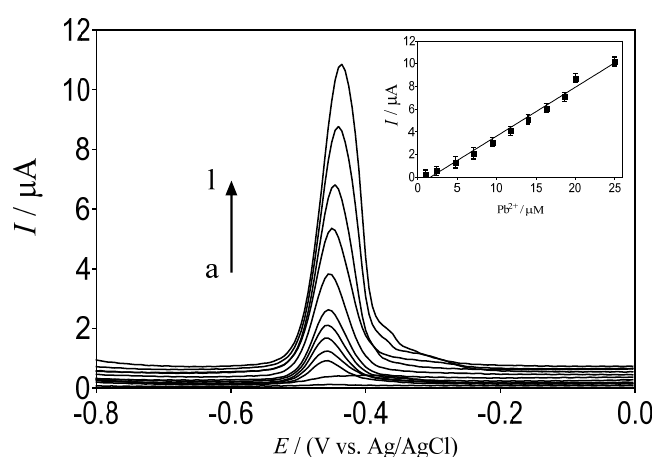
Figure 4. SWASV curves of GrRAC-70% recorded for different concentrations of Pb(II) in 0.5 M H 2 SO 4 : (a) 0, (b) 1.2, (c) 2.4, (d) 4.8, (e) 7.1, (f) 9.5, (g) 11.8, (h) 14.0, (i) 16.3, (j) 18.6, (k) 20.8, (l) 25 µ M. Inserts: plots of the electrochemical response, in terms of current, as a function of the lead concentration. The LOD was found to be 0.3 µ M. Compared with DPASV, SWASV produced much Table 1. Comparison of the analytical parameters of the sensors reported in the literature for the determination of Pb(II). Electrodes Method